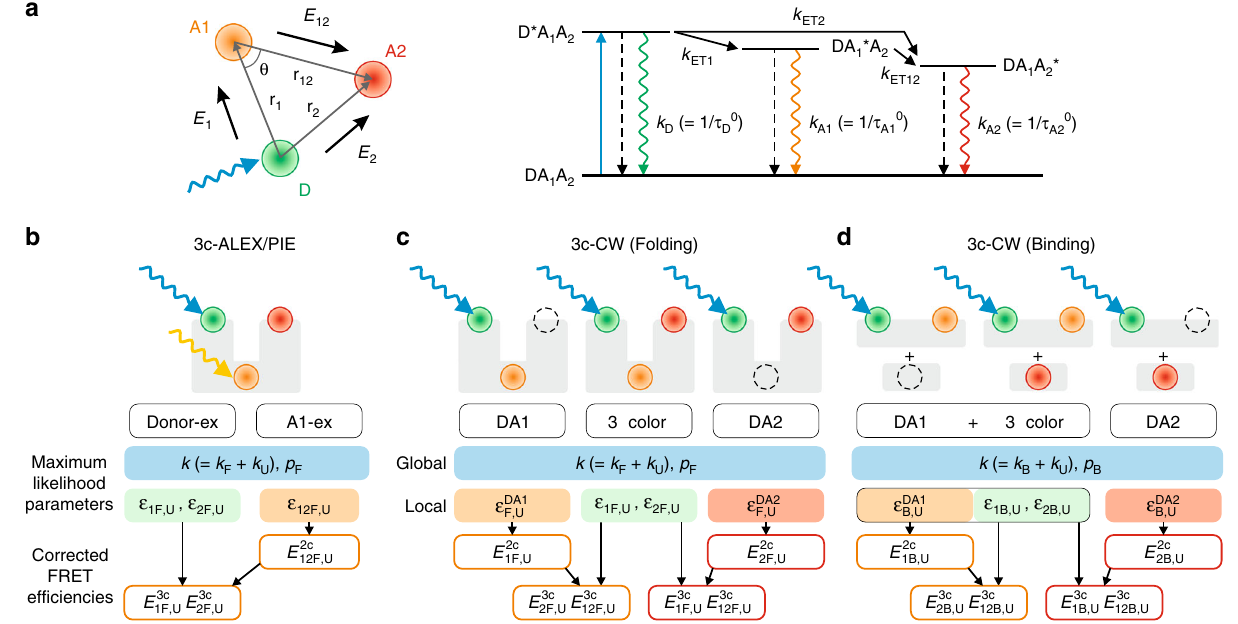
Fig. 1 Three-color FRET. a When the donor (D) is excited by a laser (blue arrows), the excited energy decays to the ground state either through the radiative (rippled arrows) or non-radiative pathways (dashed arrows) with rate constant k D or the excited energy is transferred to A1 and A2 with transfer rates k ET1 and k ET2 , respectively. The excited state energy of A1 can also be transferred to A2 with a transfer rate k ET12 . The two-color FRET ef fi ciencies ( E 1 , E 2 , and E 12 ) are the ef fi ciencies of the energy transfer between corresponding two dyes in the absence of a third dye. b Three-color alternating laser excitation or pulse-interleaved excitation (3c-ALEX/PIE) scheme. A molecule (light gray) containing all three fl uorophores is excited by a donor excitation laser (Donor-ex) and an A1 excitation laser (yellow rippled arrow, A1-ex) alternately. The parameters are determined from the global analysis of the photon trajectories. The relaxation rate k and the population of the folded state p F are global fi tting parameters. The fractions of acceptor 1 ( ε 1 ) and acceptor 2 ( ε 2 ) photon count rates in the folded (F) and unfolded (U) states are determined from the photon trajectories by D excitation. From the trajectories by A1 excitation, the fraction of A2 count rate, ε 12 , is determined. These acceptor fractions are converted to FRET ef fi ciencies de fi ned in ( a ) (see Methods). c The global analysis scheme of three- and two-color segments collected in a three-color CW donor excitation (3c-CW) folding experiment. From the two-color acceptor fractions, ε DA1 and ε DA2 , two-color FRET ef fi ciencies E 1 2c and E 2 2c are obtained, respectively. Using these values, two sets of three-color FRET ef fi ciencies can be calculated and compared. d The global analysis scheme in a three-color CW donor excitation (3c-CW) binding experiment. The three- color and DA1 parts of the photon trajectories cannot be separately analyzed as in ( c ) because the unbound state is always two-color (DA1), whereas the bound state is either three-color or two-color (DA1) due to the binding to either A2-labeled (middle) or A2-unlabeled (left) binding partner. The three- color FRET ef fi ciencies can be determined similarly using the acceptor fractions obtained from the maximum likelihood